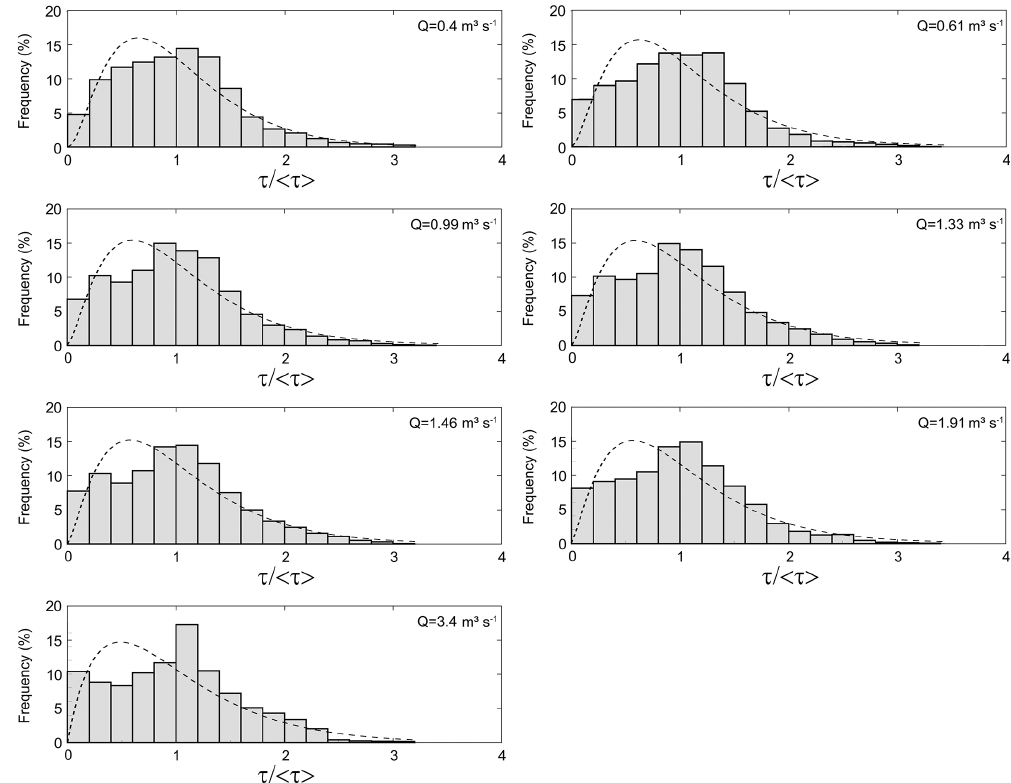
Figure 3. Frequency distributions of mean-normalized shear stress ( τ/ (cid:104) τ (cid:105) ) for the seven discharge levels. Fitted gamma distribution curves are shown as dashed lines. Discharges values are indicated in the upper-right corner of each panel.